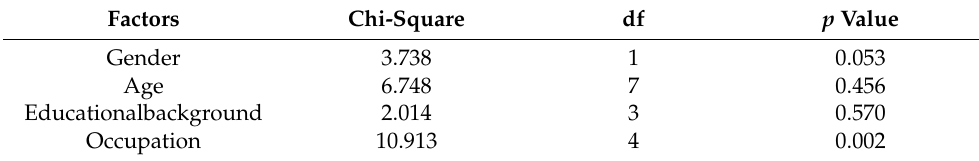
Table 8. Factors affecting choice to consume insects in Limpopo, South